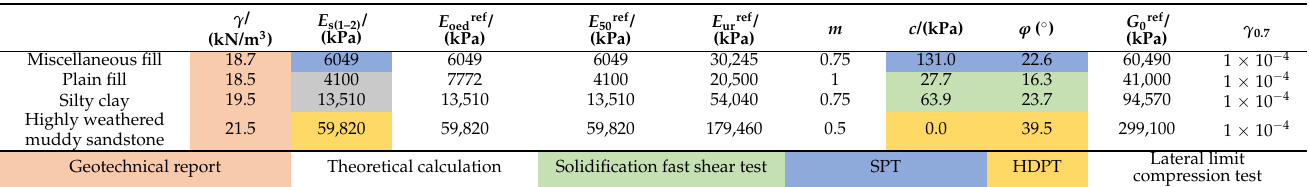
Table 4. Parameters in the HSS model.